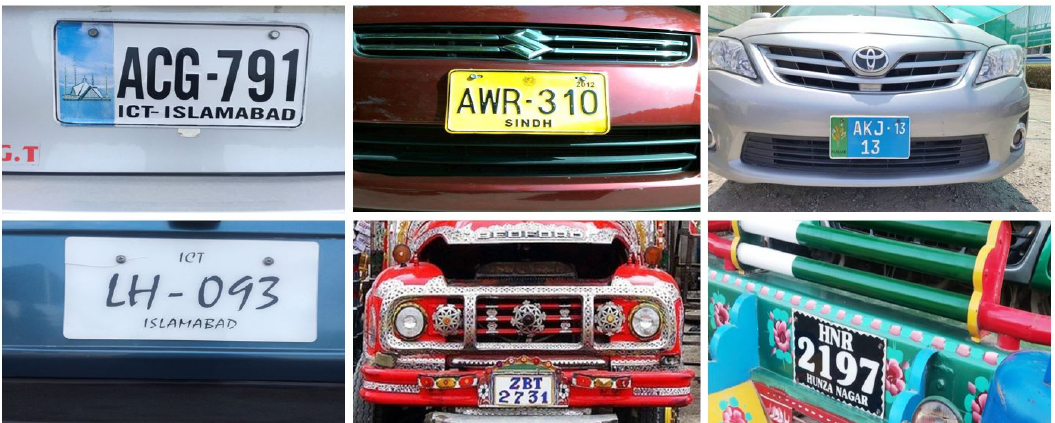
Figure 1. Overview of Pakistani license plates (LPs) with various background, foreground, characters fonts and